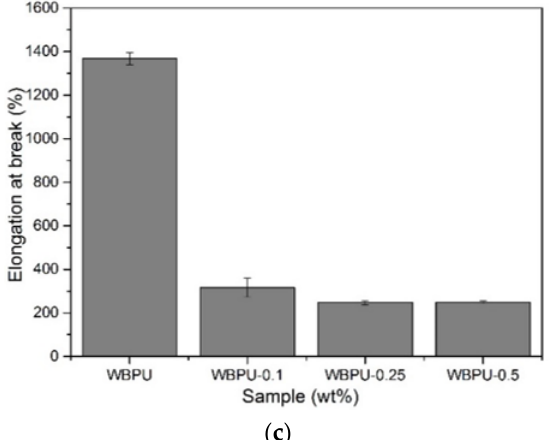
Figure 4. ( a ) Young’s Modulus, ( b ) tensile strength, and ( c ) elongation at break of WBPU and WBPU-CNF nanocompos- ite